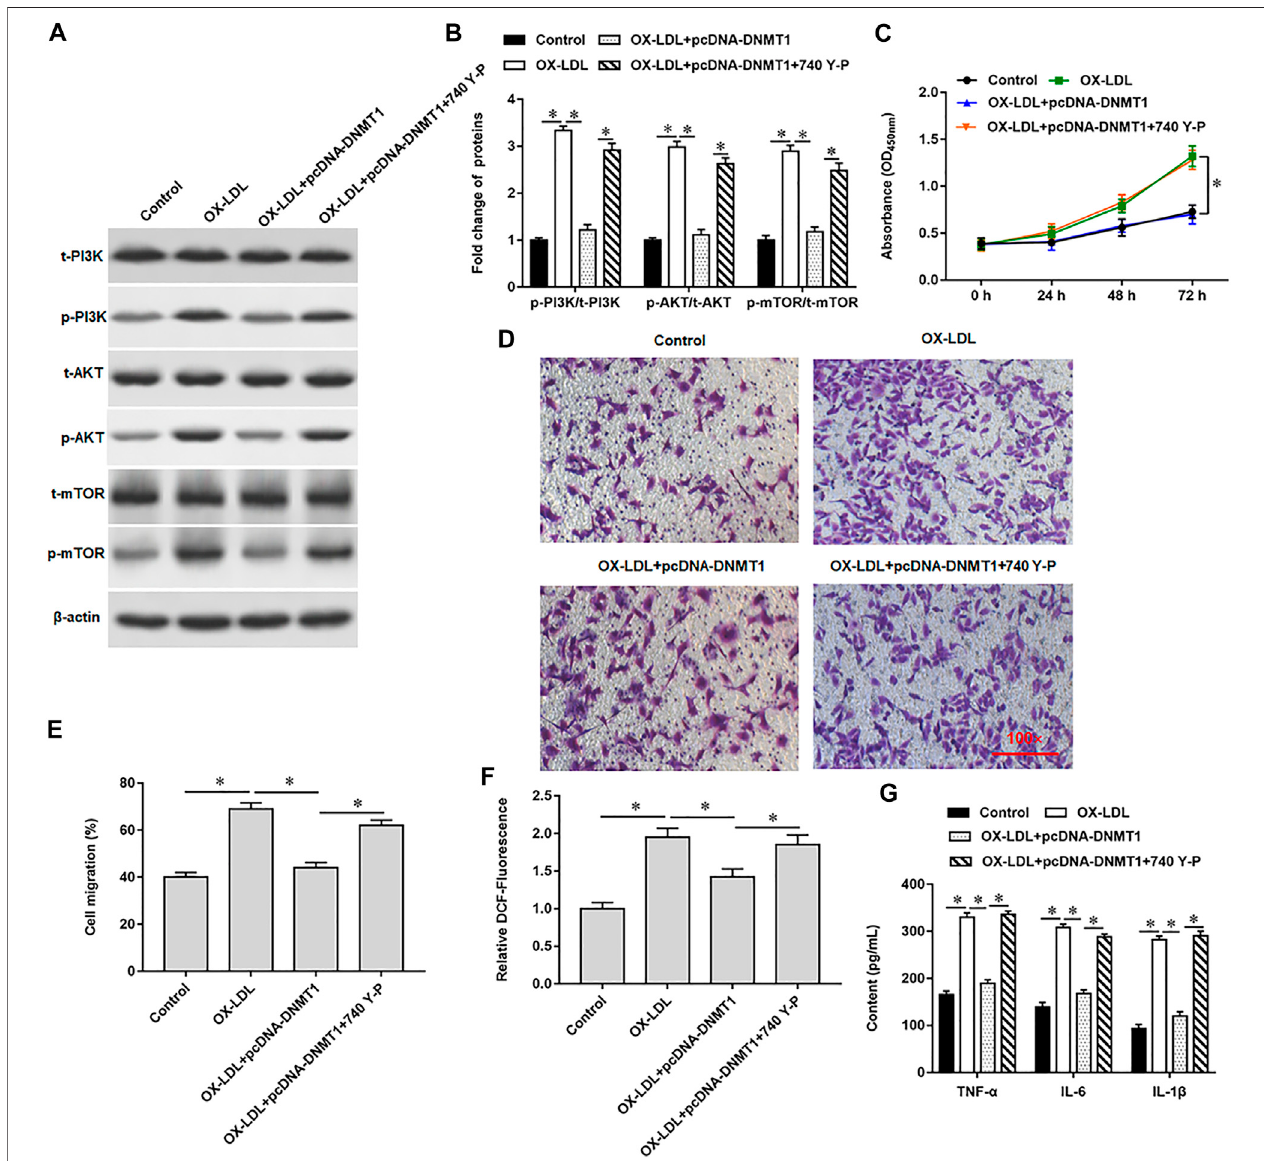
FIGURE 5 | Hypomethylation of Rnase6 promoter activated PI3K/AKT/mTOR signaling pathway. MOVAS cells were induced with OX-LDL for 48 h, pcDNA- DNMT1 (2 μ g/ml) was transfected into the cells, and the cells were intervened with PI3K agonist. (A,B) . Fold change of signaling pathway-related proteins in cells were analyzed byWestern blotting. (C) . CCK-8 assay was used to analyzed the proliferation of MOVAS cells. (D,E) . Trans -well assay was used to measure the cell migration. (F) . ELISA was used to detect the content of ROS. (G) . Relative secretion levels of TNF- α , IL-6 and IL-1 β were analyzed by ELISA kits. β -actin was used as an internal reference. N (cid:2) 6, * p <